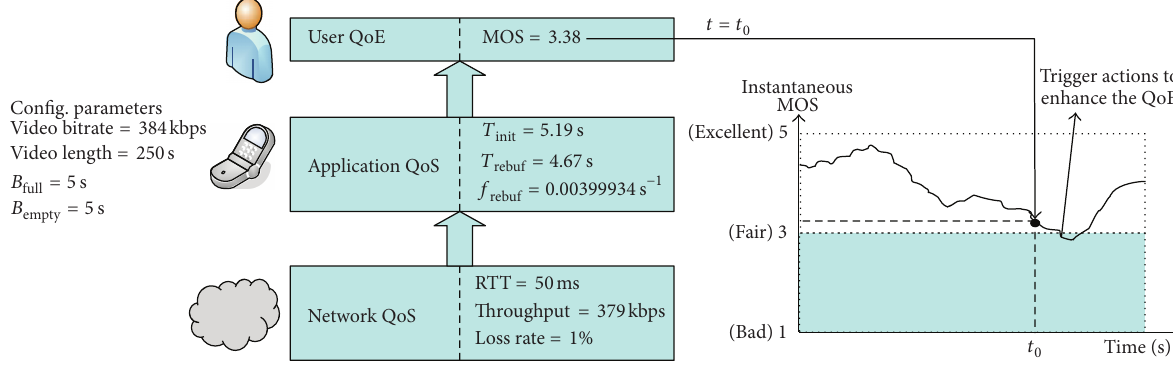
F 6: Example of MOS evaluation for YouTube